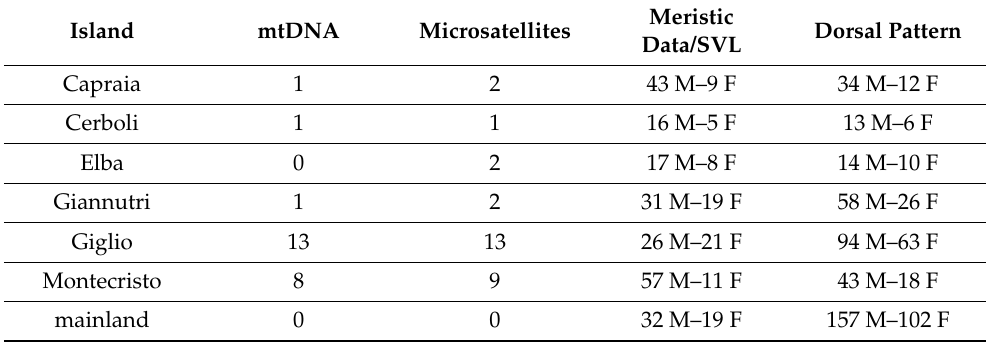
Table 1. Number of successfully analyzed samples for each island in each analysis. Samples are divided by sex for meristic and DP data (M = males, F = females). This table does not include the cytb sequences coming from